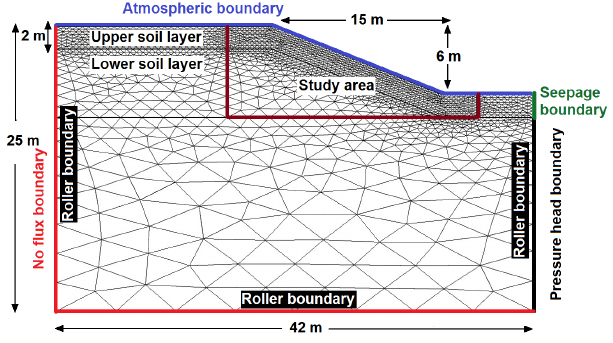
Figure 2. Computational mesh and boundary